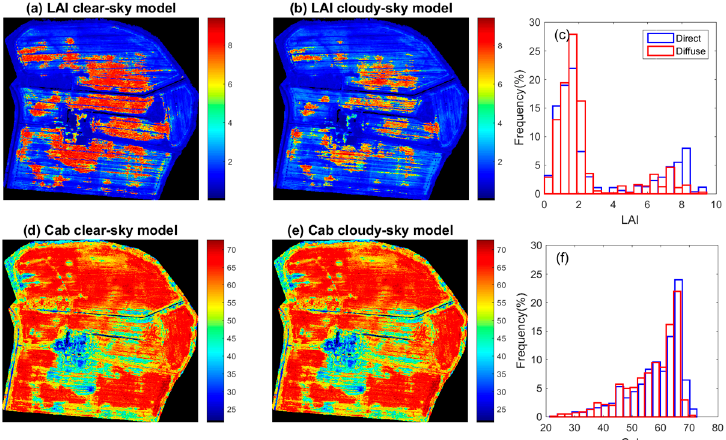
Figure 4. Spatial distribution of LAI and C ab from clear-sky model and cloudy model and the distribution of corresponding values over Vic-4 wheat field in 2016. ( c , f ) represent the distribution of LAI and C ab , respectively. ‘Direct’ and ‘Diffuse’ on ( c , f ) correspond to ‘clear-sky’ and ‘cloud-sky’ models, respectively. ( a ) LAI clear-sky model. ( b ) LAI cloudt-sky model. ( d ) Cab clear-sky model. ( e ) Cab cloudy-sky